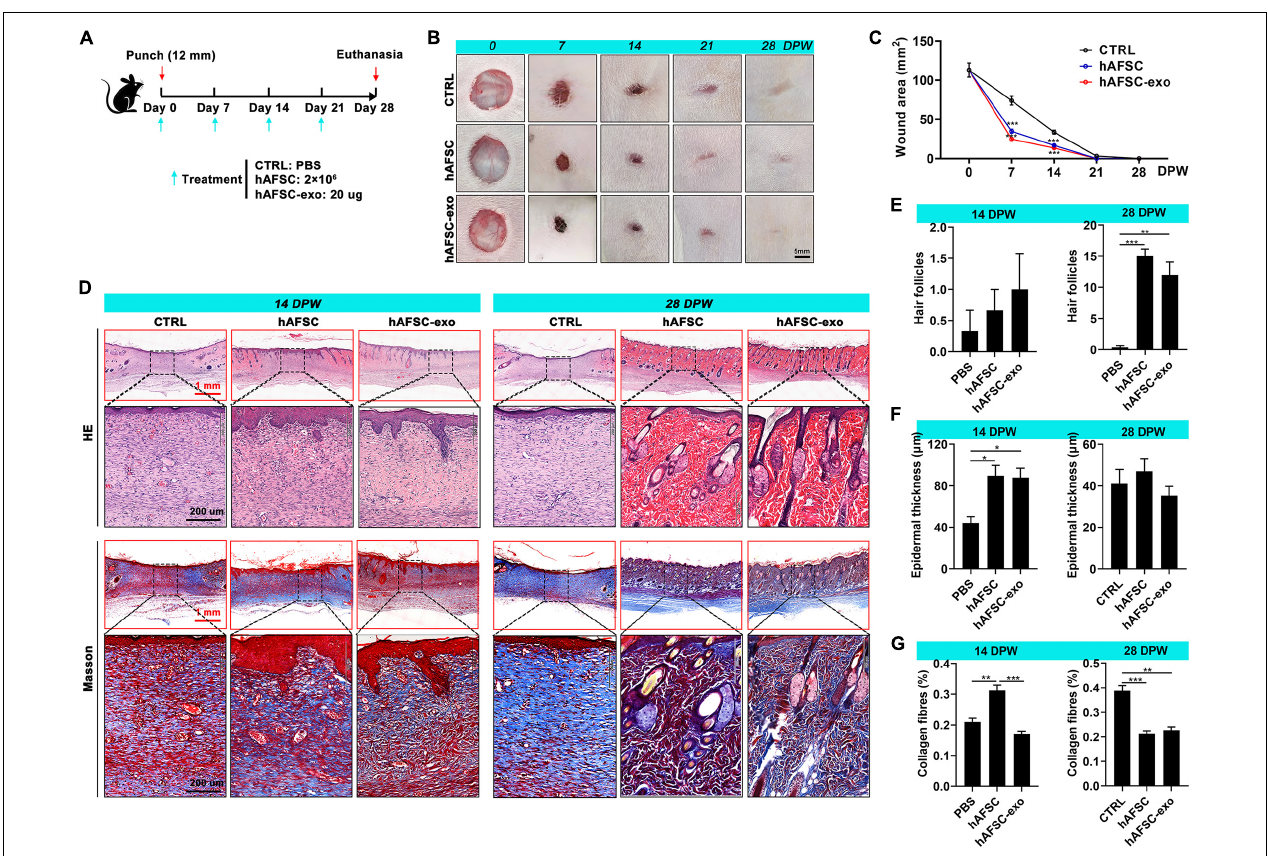
FIGURE 2 | hAFSC-exo accelerated the wound healing rate and improved the regeneration quality in the full-thickness cutaneous-wounded rats. (A) Schematic representation of the experimental design. The full-thickness cutaneous-wounded model (12 mm diameter) was established on the shaved skin of the dorsal region. The rats were then administered treatments by local injection every 7 days: CTRL (PBS), hAFSC (2 × 10 6 cells), and hAFSC-exo (20 µ g). (B) Morphological changes in the wound healing process (scale bar = 5 mm). (C) Changes in wound area during wound healing. (D) H&E and Masson staining of the healing tissues; scale bar (red) = 1 mm; scale bar (black) = 200 µ m. (E–G) Number of hair follicles/field (20 × ), epidermal thickness, and percentage of collagen fibers (blue area in Masson staining) in the healing tissue according to histology. * P < 0.05; ** P < 0.01; *** P < 0.001; mean ± SD; n = 5. CTRL, control; DPW, days